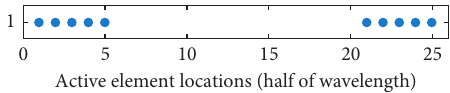
Figure 3: Type 1 array configuration.